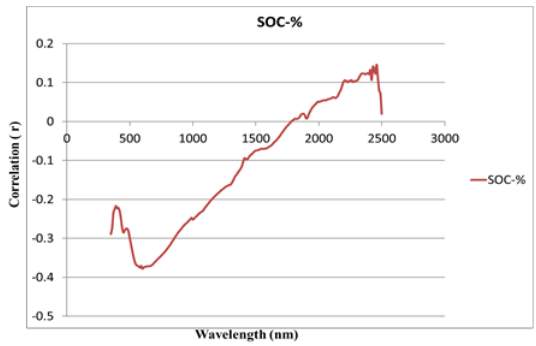
Figure 3. Correlation of SOC with reflectance spectra at different wavelengths